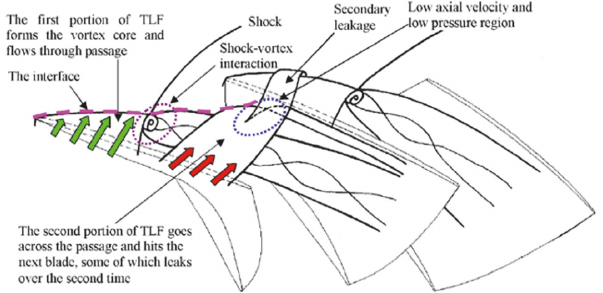
Figure 4: The schematic of TLF structure at NS ([12]). Figure reproduced from LIN et al.